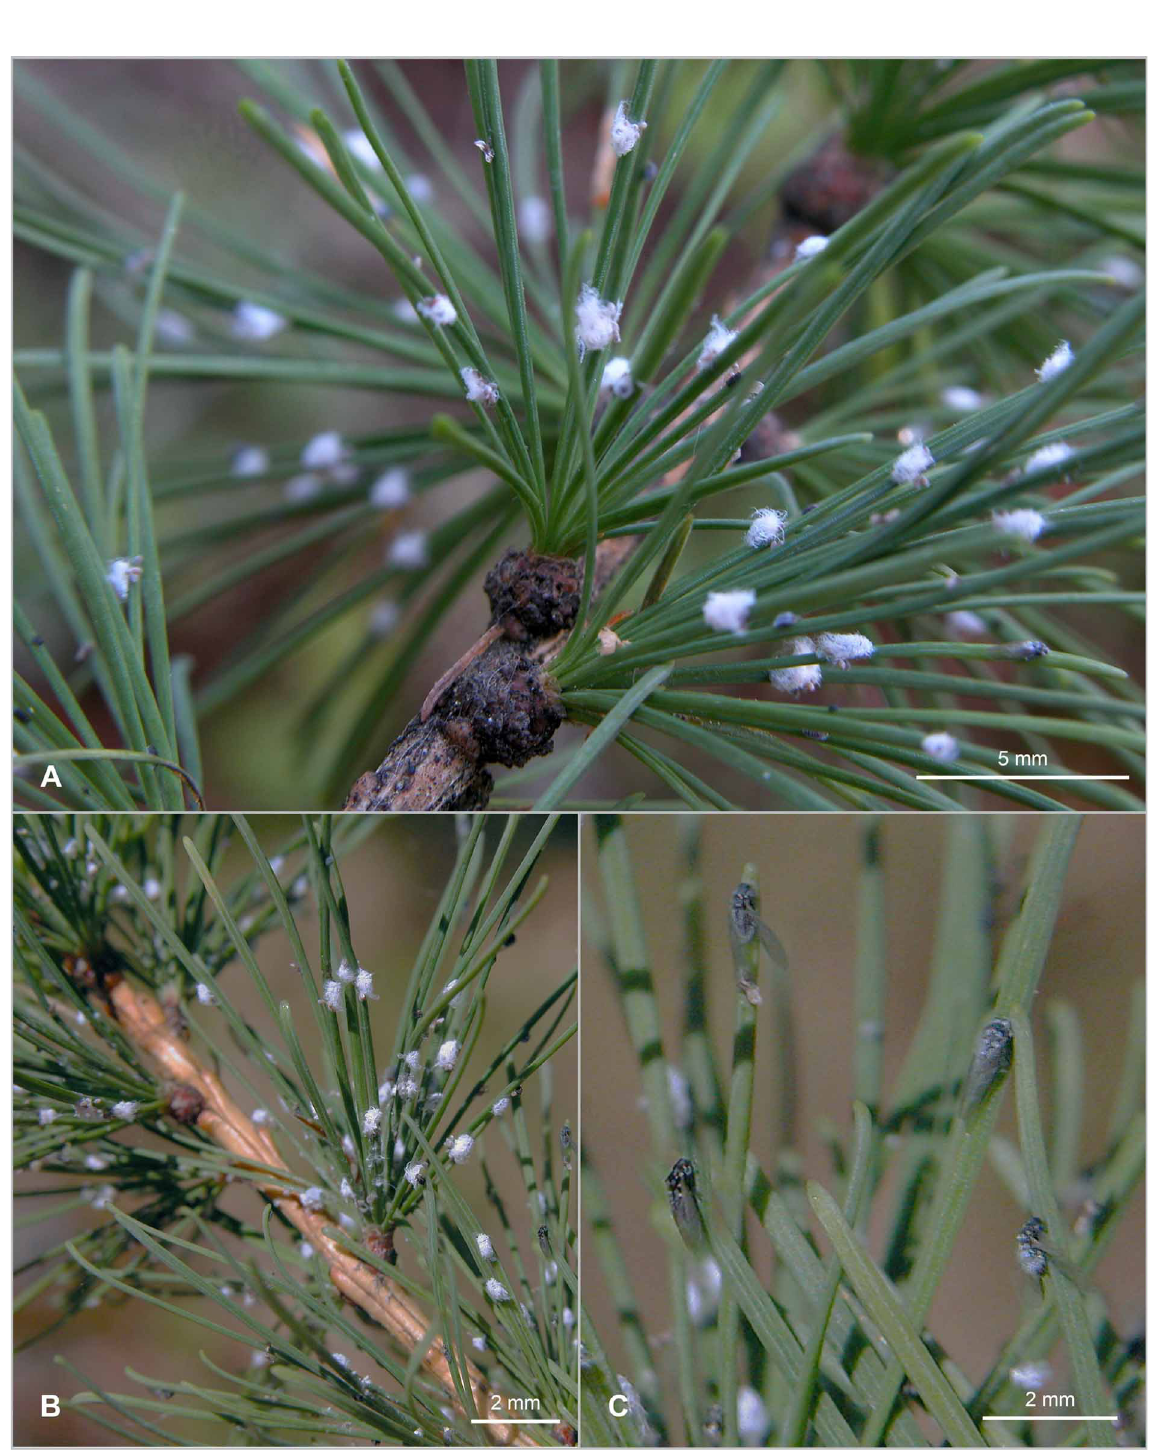
Fig. 59. Adelges (Adelges) laricis Vallot, 1836. Apterous and alate progredientes on Larix sibirica